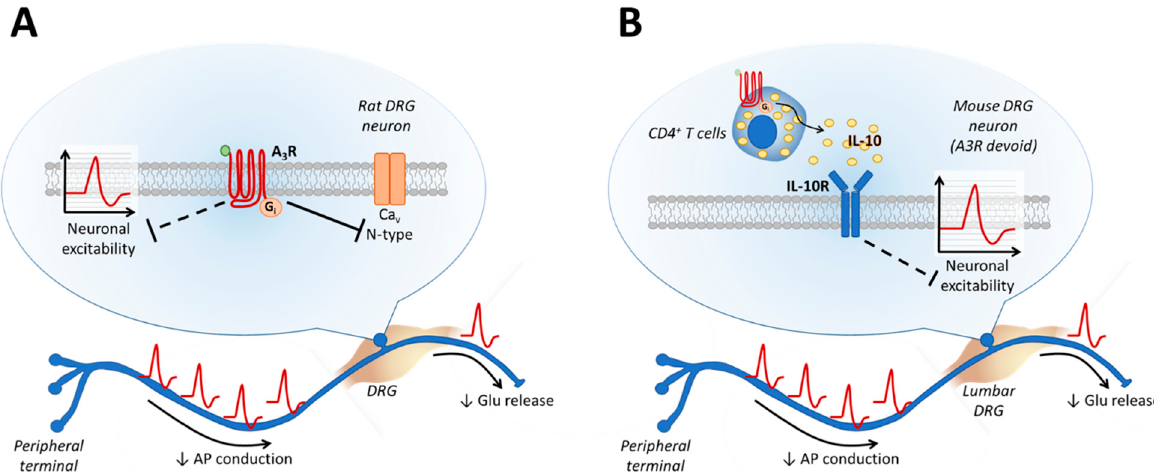
Figure 3. Adenosine A 3 receptors and peripheral mechanisms for pain control. ( A ) A 3 receptors (A 3 Rs) expressed on rat DRG neurons decrease action potential (AP) firing by blocking neuronal excitability. The same receptor subtype also inhibits N-type voltage-gated calcium channels (Ca V ), thus reducing glutamate (Glu) release at the synapse [67]. ( B ) In a mouse model of CCI, A 3 Rs expressed on CD4 + T cells, but not on mouse DRG neurons in this rodent species, promote interleukin-10 (IL-10) release, which, by activating IL-10 receptors (IL-10R) on DRG neurons, reduces neuronal excitability [73].